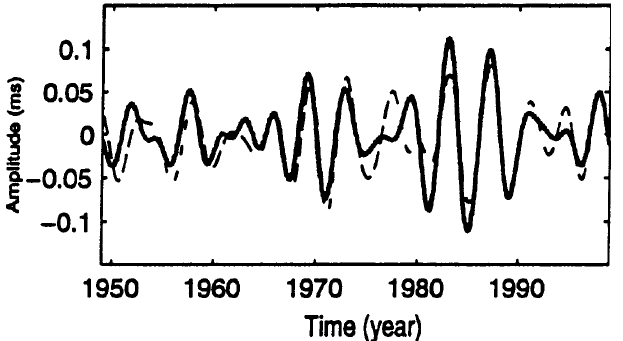
Fig. 13. Interannual variations at the triennial-quadrennial band (3 to 5 years) of AAM (i.e. TAAM ) ( bold ) and MSOI/10 ( dashed )